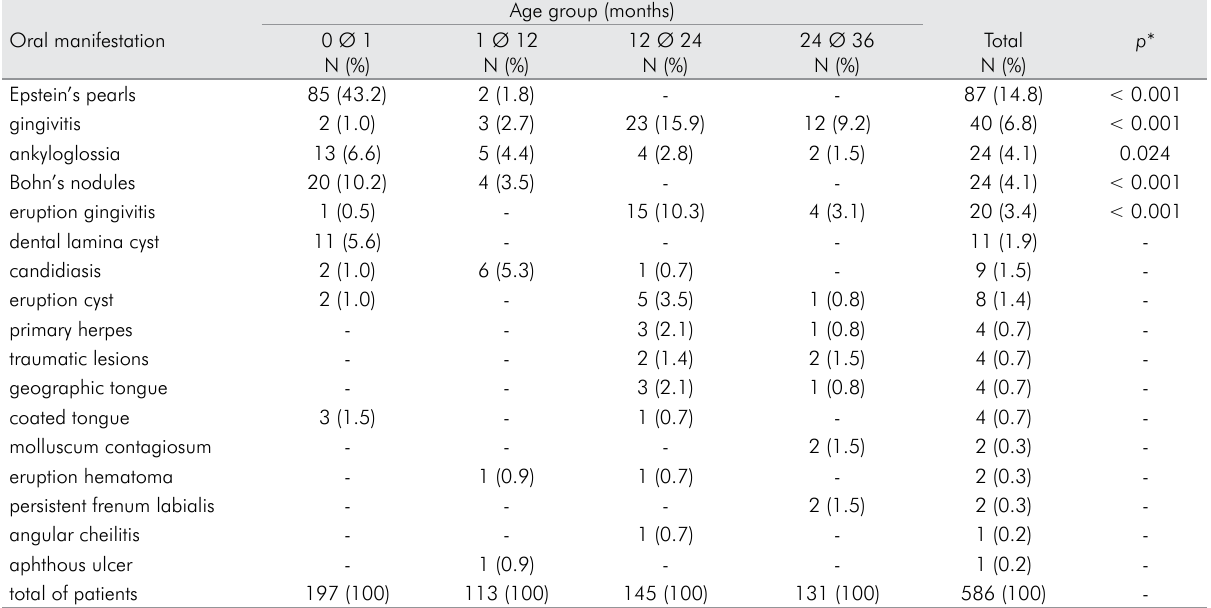
Table 2. Prevalence of oral manifestations according to age group.